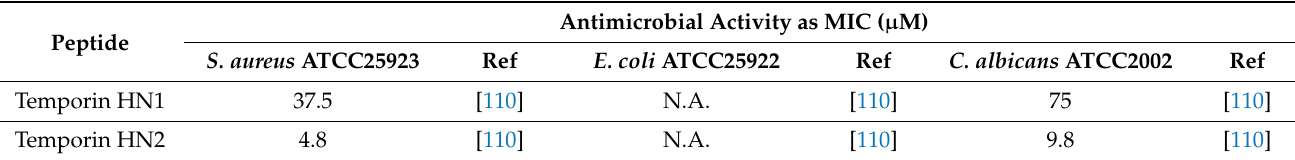
Table 9. Antimicrobial activity against selected microorganisms of temporins from Odorrana .